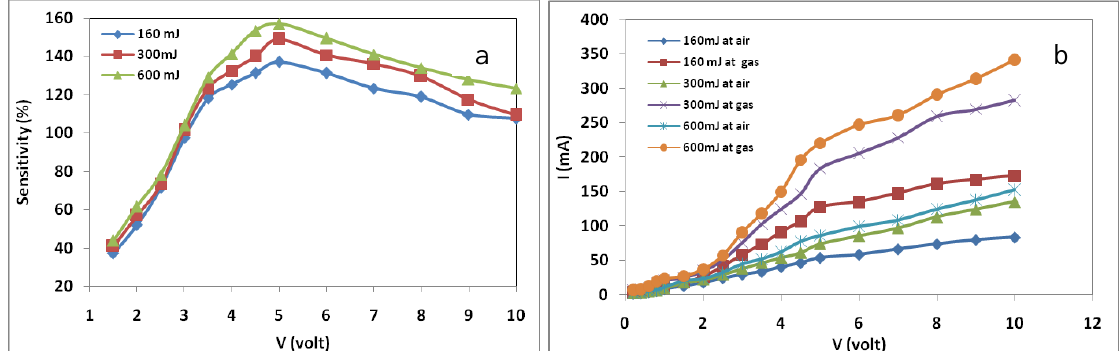
Fig. 13: a: The sensitivity of Al/AuNPs/PS/c-Si /Al. b: I-V characteristic for Al/AuNPs/PS/c-Si /Al before and after exposed to